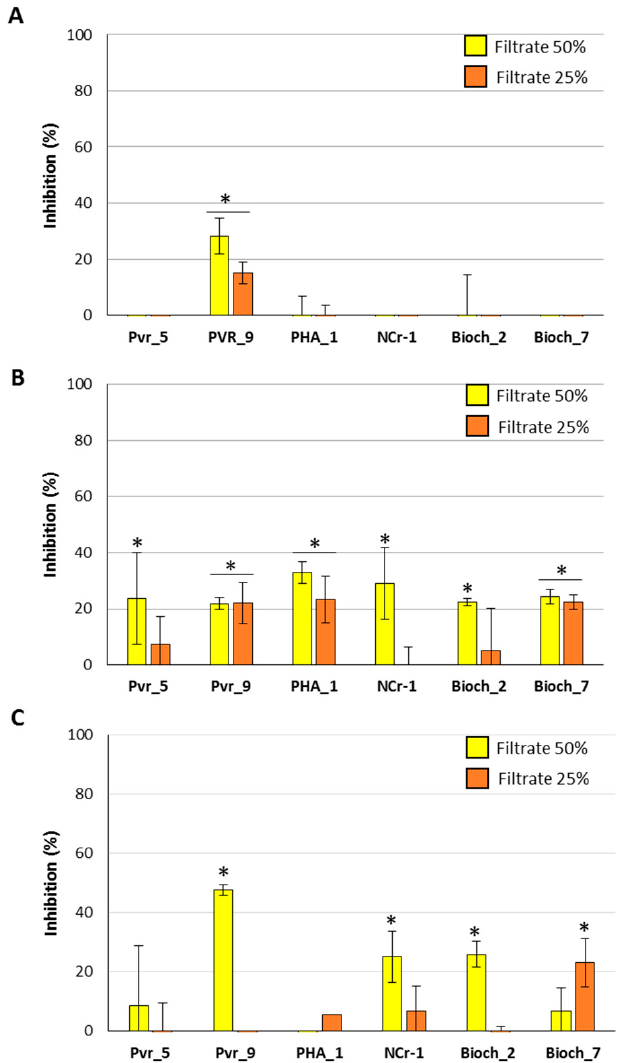
Figure 3. Antifungal activity of filtered bacterial culture broth against A. flavus ( A ), F. verticillioides ( B ), and F. proliferatum ( C ). Cultures of 5 × 10 3 of fungal conidia/well were amended with 25 or 50% bacterial broth. Data are presented as percentage inhibition with respect to the control (fungal cultures only) and are the means of six biological replicates ± standard deviation (S.D.). Asterisks indicate statistically significant differences between control and co-inoculated cultures according to ANOVA and Tukey’s test ( p < 0.05).